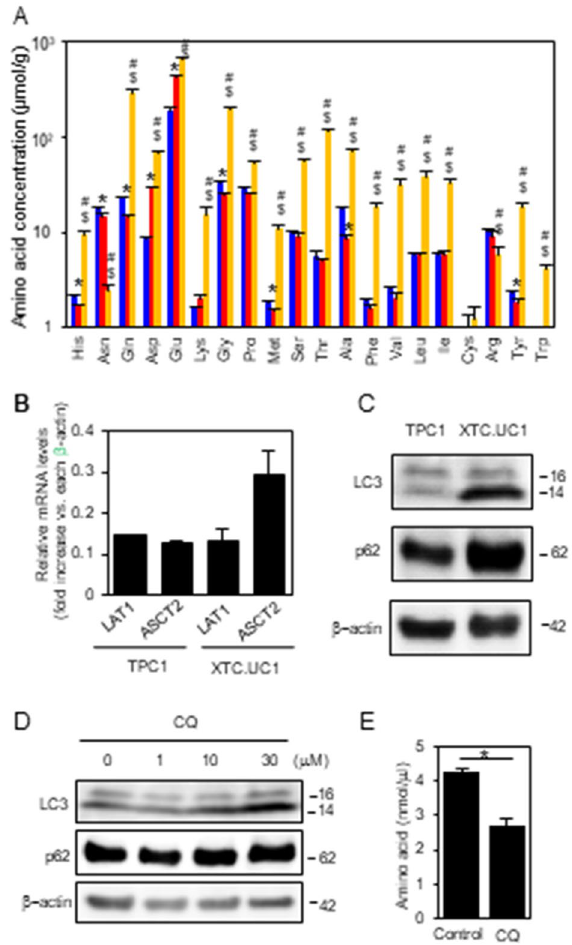
ASCT2, mRNAs, WB for LC3, p62 and β-actin and intracellular amino acid measurements were performed as described in the “Materials and methods”. In A, blue, Nthy-ori 3-1; yellow, XTC.UC1; red, TPC1 cells. Data are images are shown in Supplementary Fig.